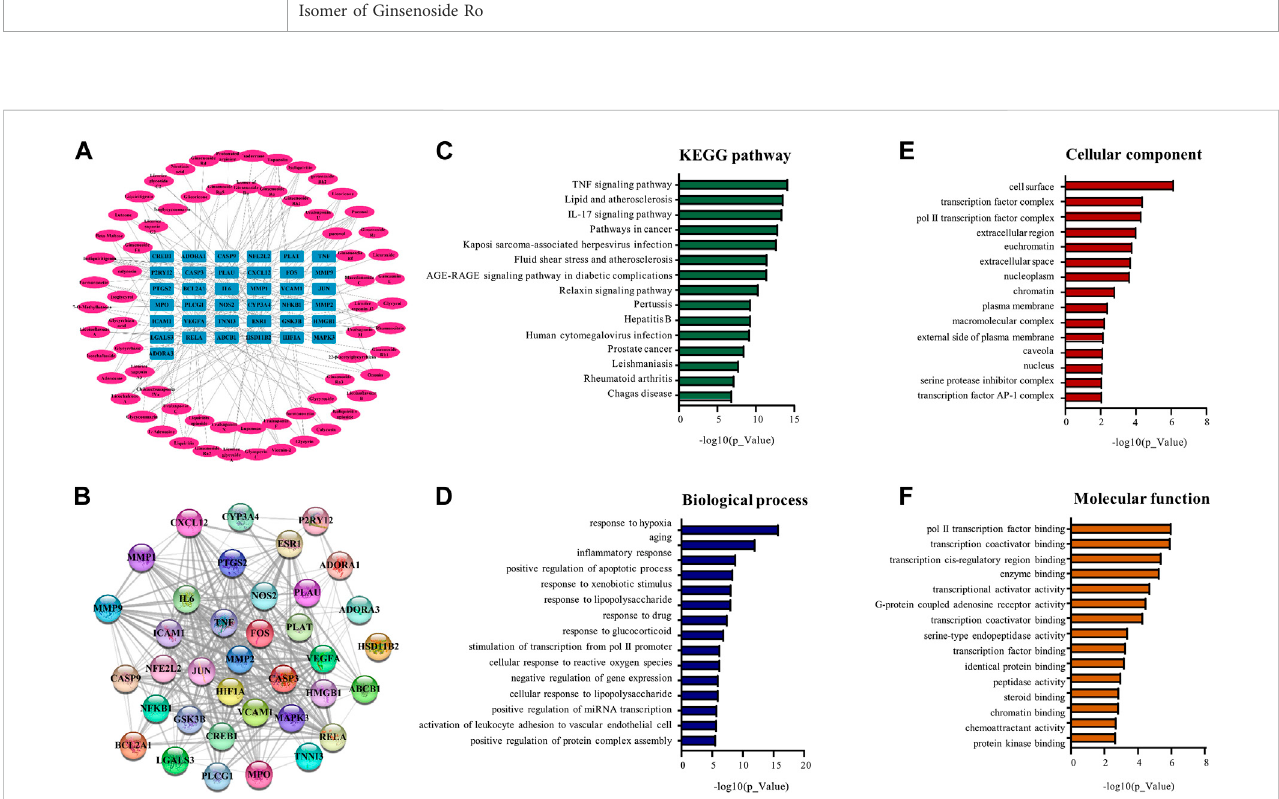
FIGURE 5 Network pharmacology analysis for the compound-target relationship and the signaling pathways. (A) Compound-target relationship. The outside oval shapes represent the active compounds whereas the inner rectangles represent the targets. (B) Protein-protein interaction network of the targets. The colored nodes represent BYDE targets whereas the edges represent the interactions between the proteins. (C) The top 15 signaling pathways from the KEGG analysis. (D) The top 15 biological process from enrichment analysis. (E) The top 15 cellular components from enrichment analysis. (F) The top 15 molecular functions from enrichment